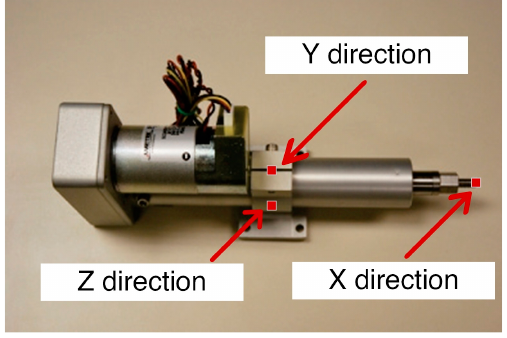
Figure 4. Directions of the accelerometer. In this study, there were four classes of data: the normal state, ball screw return channel jam, screw surface spall, and motor failure. Detailed information on the dataset is provided in Table 1. The acceleration signal of the four states from the three directions in experiment 3 is taken as an example in Figure 5, respectively. The signals in the three directions have different amplitudes and